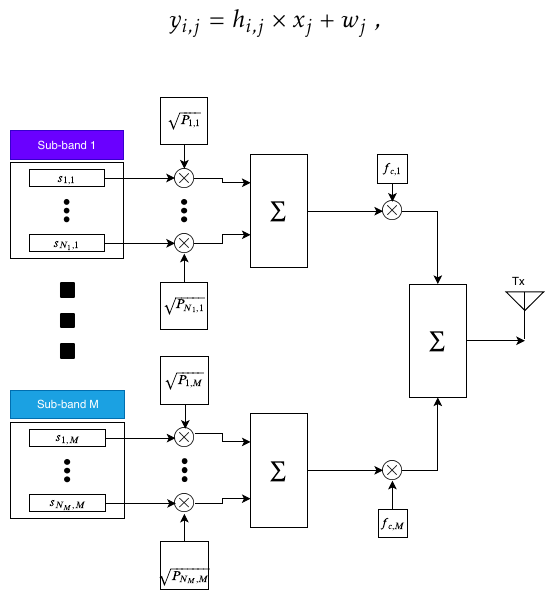
Figure 2. General P-NOMA transmitter